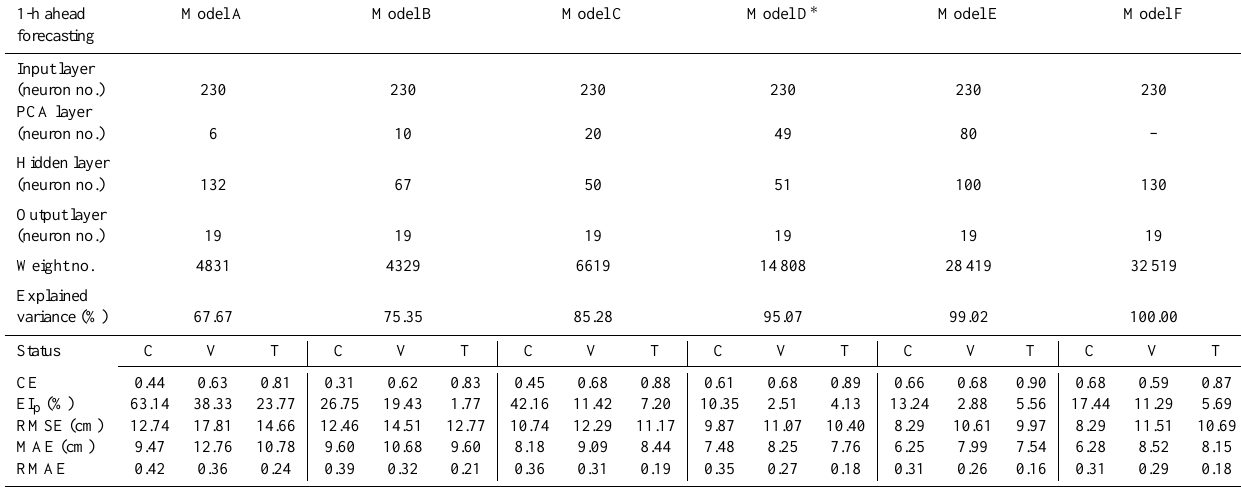
Table 3. The structures and performances of five RiHNNs (Models A ∼ E) and one feed-forward neural network (Model F). 1-h ahead